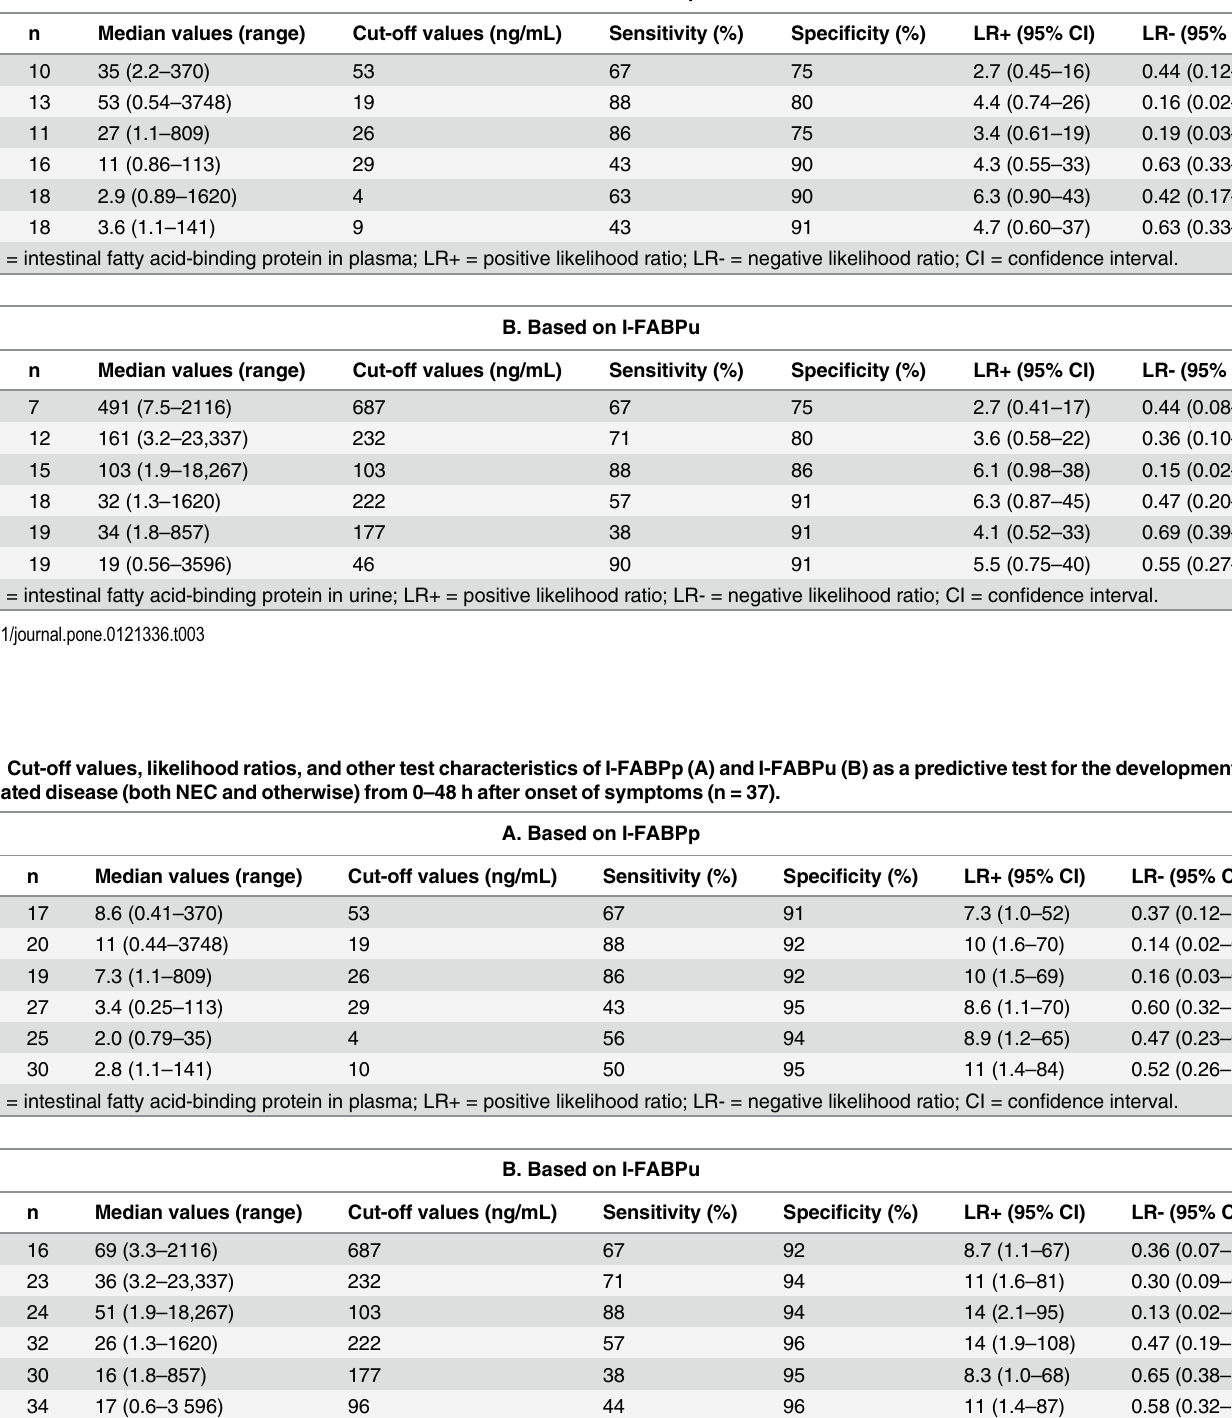
Table 3. Cut-off values, likelihood ratios, and other test characteristics of I-FABPp (A) and I-FABPu (B) as a predictive test for the development complicated NEC (after NEC has been diagnosed) from 0 – 48 h after onset of symptoms (n = 22). A. Based on I-FABPp